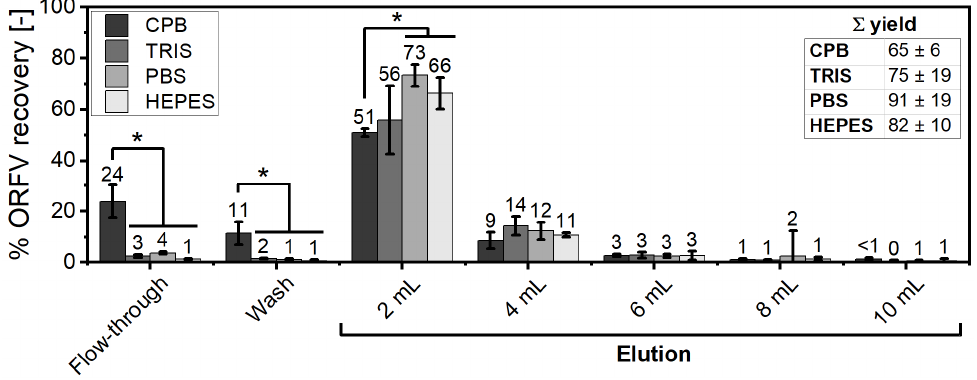
Figure 3. Performance of the steric exclusion chromatography (SXC) depending on the buffer. The Orf virus (ORFV) was processed via SXC (load: 8% PEG 8000 (polyethylene glycol, 8000 Da); elution: 0% PEG, 0.4 M NaCl) in different buffering systems of neutral pH and physiological conductivity: 0.1 M CPB (dark grey), 20 mM TRIS-HCl (medium grey), PBS (light grey), and 0.1 M HEPES (white). The pre-mixed ORFV/PEG solution was directly applied to the column without an incubation time. The triplicate runs were fractionated into flow-through, i.e., sample application, wash, and elution. The elution itself was fractionated into 5 × 2 mL. Each set of three runs was analyzed regarding the concentration of infectious ORFV. On a volumetric basis, the recoveries were calculated relative to the respective feed. The statistical analysis of the recoveries was performed via ANOVA with a Tukey test ( α = 0.05) for n = 3. Asterisks (*) indicate significant differences within the respective group. Representative chromatograms may be found in the Supplementary Material Section S4.2.